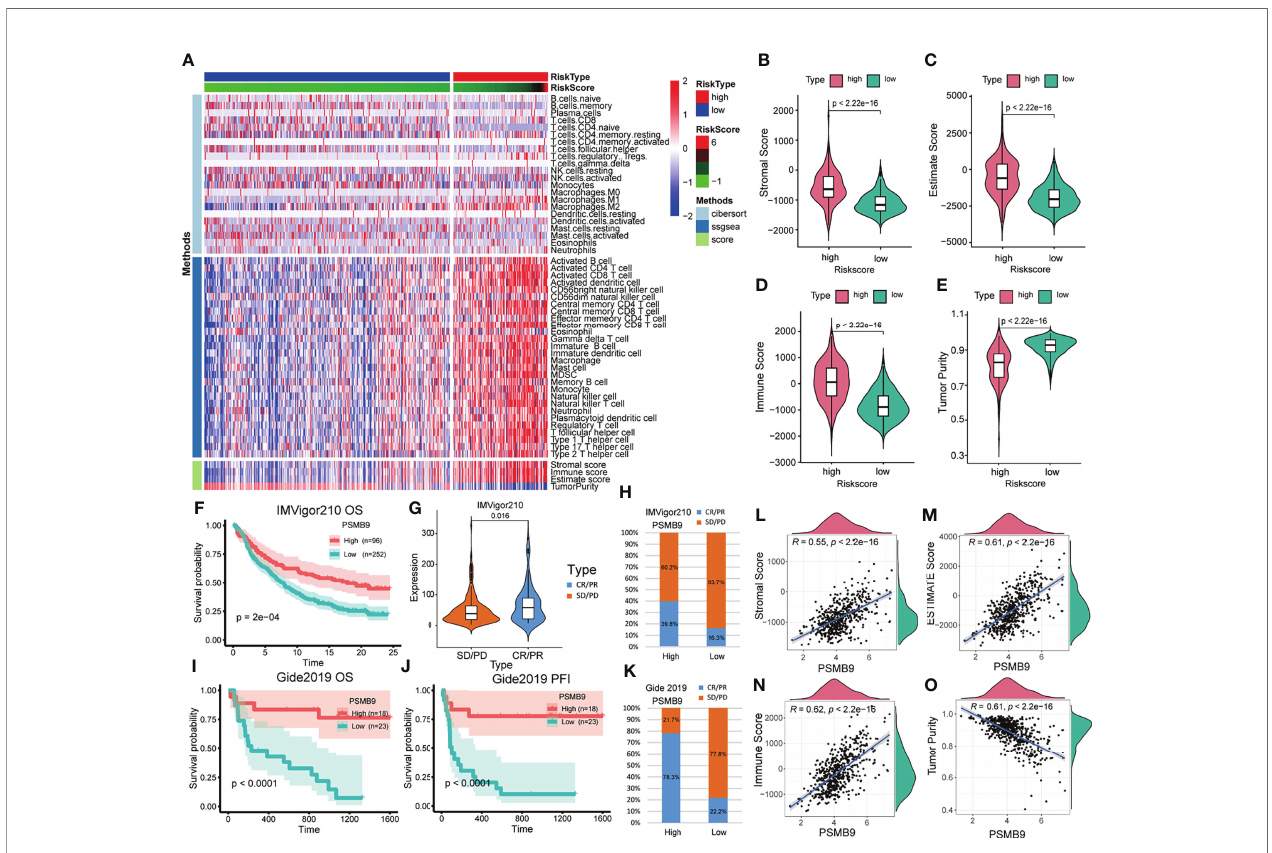
FIGURE 7 | Analysis of immune-related differences and treatment prediction. (A) Heatmap revealed the immune in fi ltration in the LGG cohort through CIBERSORT, ssGSEA and ESTIMATE algorithm. (B – E) The relevance between PSMB9 expression and immune-related score (including Stromal score, Estimate score, Immune score and Tumor purity). (F) Kaplan – Meier overall survival (OS) analysis in anti-PD-L1 (IMvigor210) cohorts in PSMB9 expression high and low group. (G) Expression of PSMB9 in different treatment response groups. (H) The proportion of the difference in response to anti-PD-L1 immunotherapy in PSMB9 high and low expression group. (I) Kaplan – Meier overall survival (OS) analysis in Gide2019. (J) Kaplan – Meier progression-free interval (PFI) analysis in Gide2019 cohort. (K) The proportion of the difference in response to anti-CTLA4 and anti-PD1 immunotherapy in PSMB9 high and low expression group. (L-O) The scatter plot con fi rmed the relationship between PSMB9 expression and immune-related